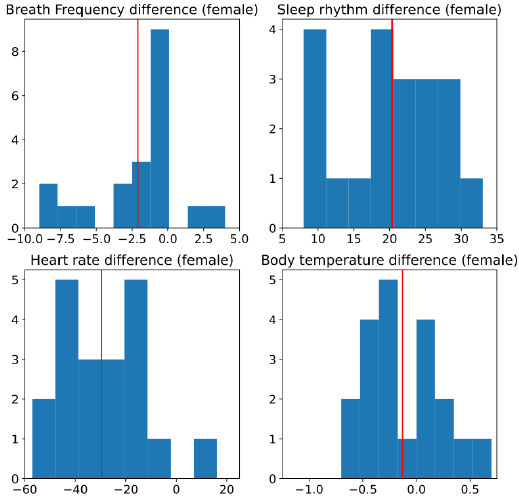
Figure 16. Histogram of difference between two conditions, without and with sensors, for female subjects. Red line is estimated mean.